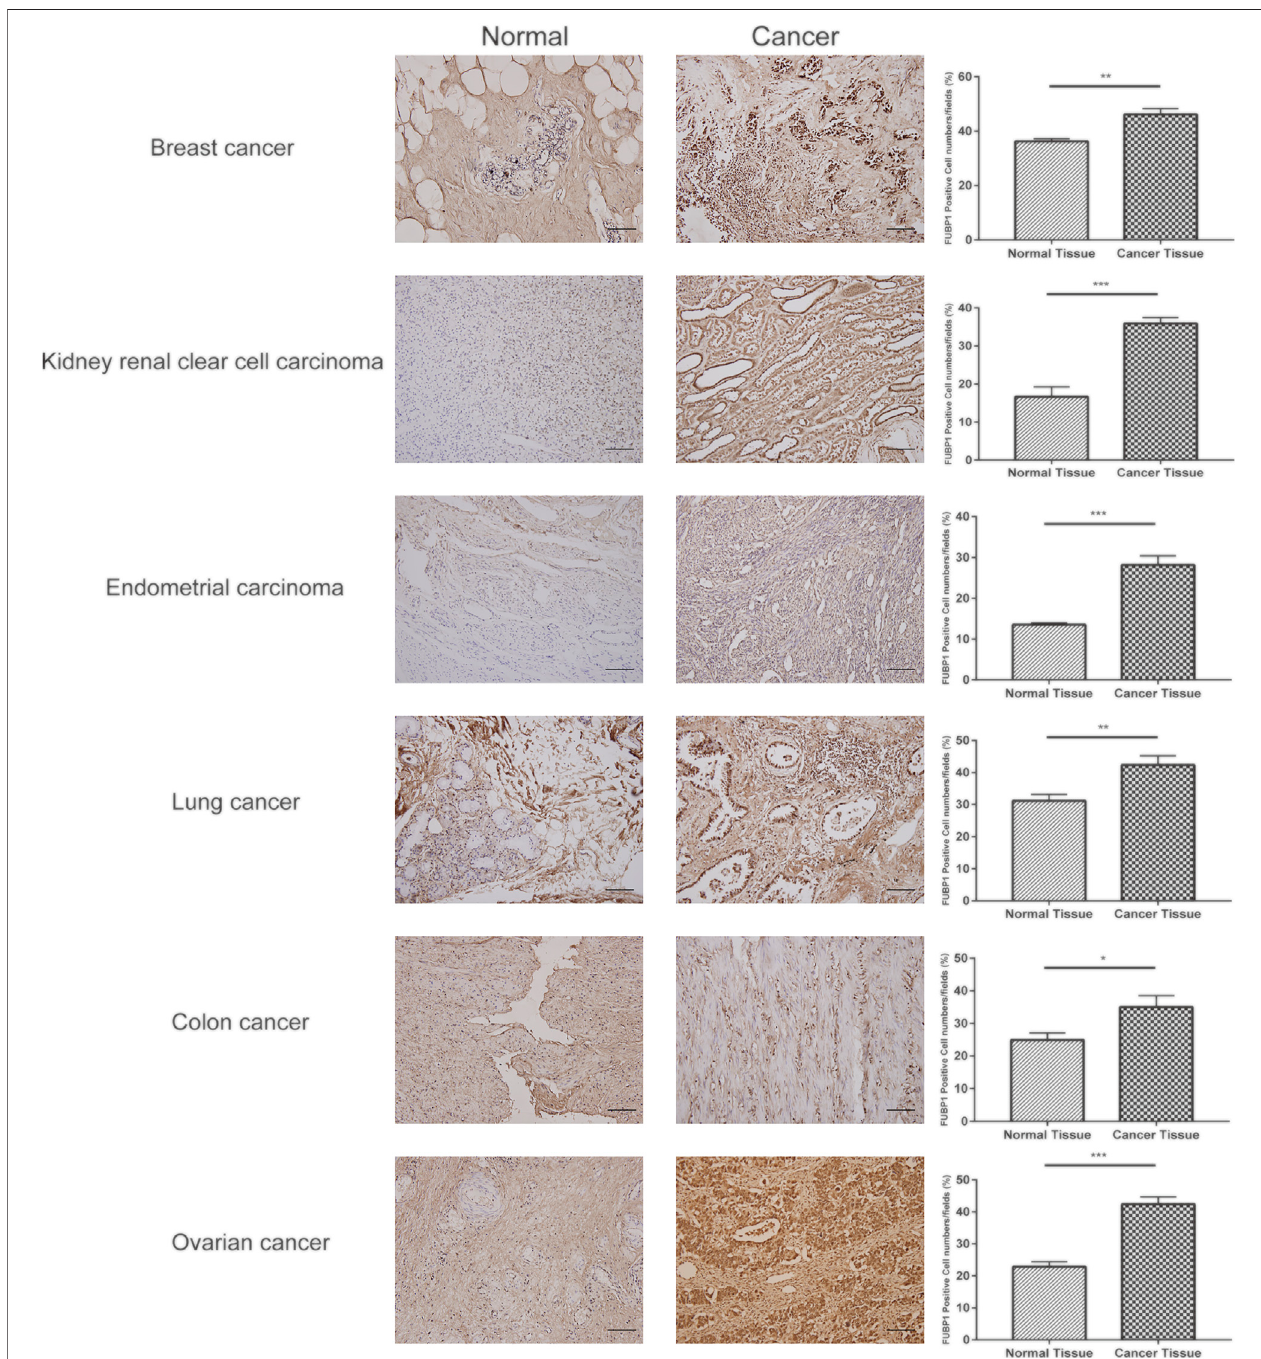
FIGURE 9 | Expression of FUBP1 showed differences between six types of tumor tissues and their normal counterparts. Representative immunohistochemistry staining of clinical specimens; scale bar = 100 μ m (magni fi cation, ×200). * p < 0.05, ** p < 0.01, *** p < 0.001.